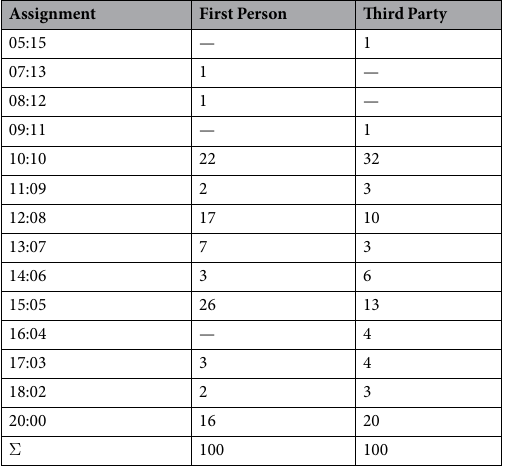
Table 1. Total distribution of dictator–recipient assignments (in €). Numbers represent the total distribution of specific dictator: recipient assignments along with the frequency in the respective